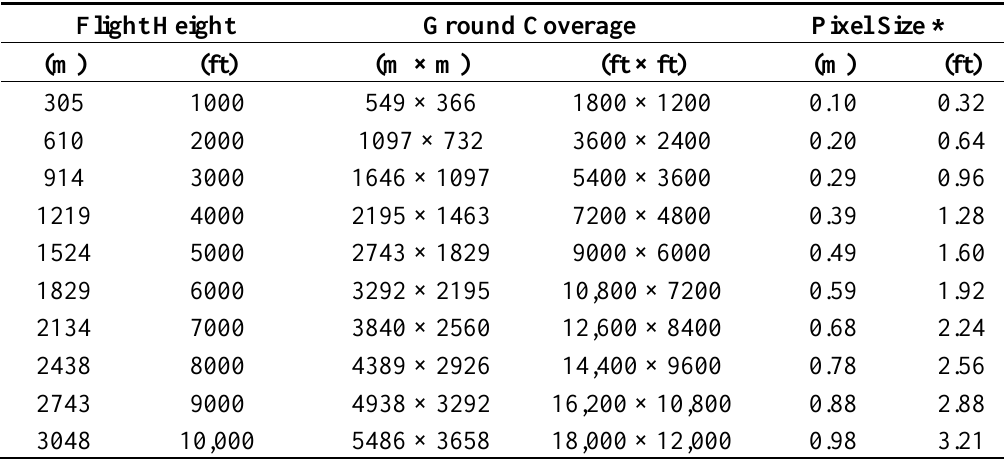
Table 2. Ground coverage and pixel size of a two-camera imaging system at different flight heights above ground